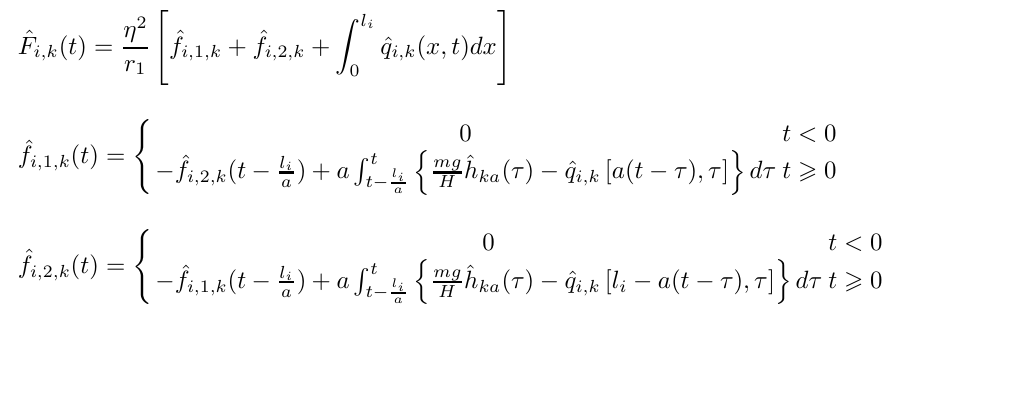
Fig. 3. Linearised dynamic response h ( t ) of a single-span cable ( f =0.1H z